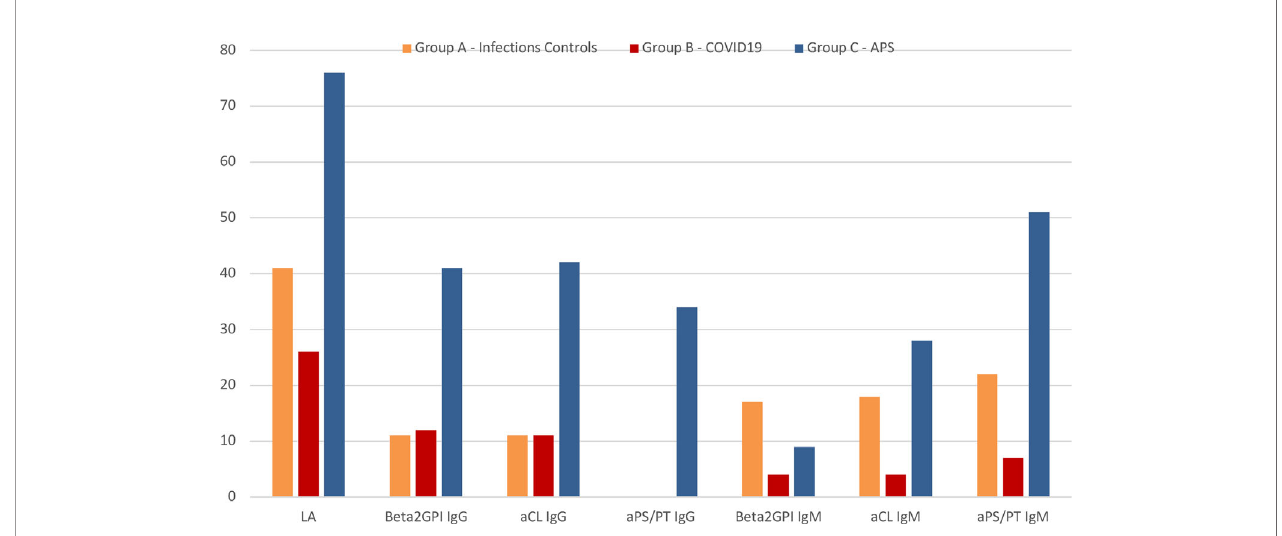
FIGURE 1 | Graphical representation of the rate of antiphospholipid antibodies positive patients between groups. APS, antiphospholipid syndrome; LA, lupus anticoagulant; aPS/PT, anti-phosphatidylserine/prothrombin antibodies; a b 2GPI, anti- b 2-glycoprotein-I antibodies; aCL, anticardiolipin antibodies; Ig,